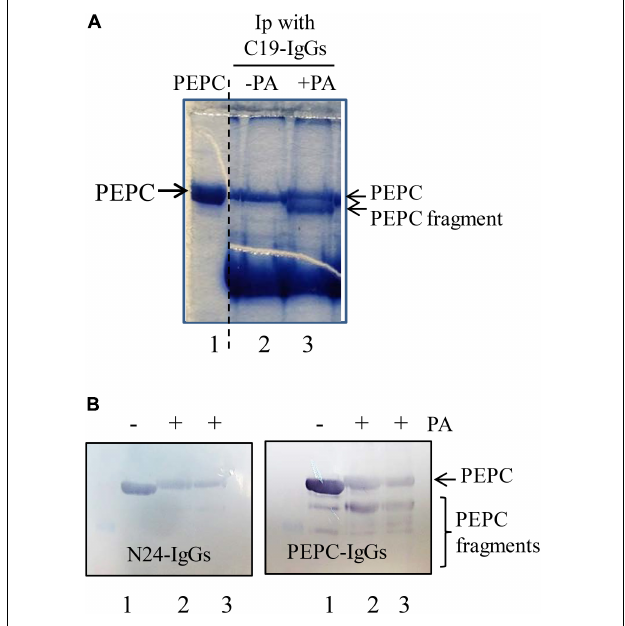
FIGURE 5 | The N -terminal of PEPC is the initial target of PA-induced proteolysis. A standard proteolytic assay as is described in M&M was performed in presence or absence of 0.25 mM PA. (A) Coomassie blue stained PEPC samples exposed to PA for 60 min at 30 ◦ C and immunoprecipitated with C19-IgG. Lane 1, PEPC prior to immunoprecipitation. Lane 2, PEPC without PA. Lane 3, PEPC in presence of PA; (B) Immunoblot analysis of PEPC exposed to PA at different times and detected using N24-IgG or PEPC-IgG. Lane 1, PEPC control without PA. Lanes 2 and 3 in B, 5 or 7 h of incubation in presence of PA,